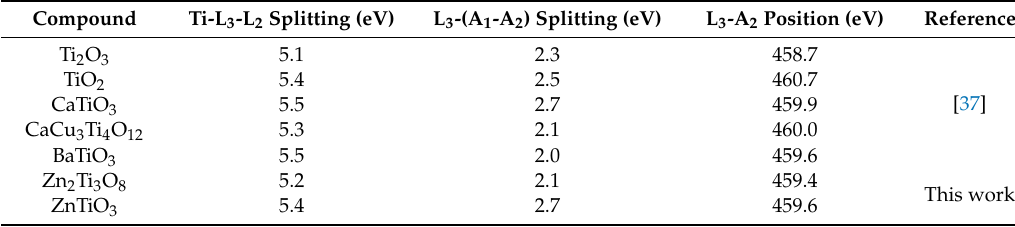
Table 1. L 3 -L 2 and A 1 -A 2 edge separation and A 2 position on the L 3 edge in Ti EELS.